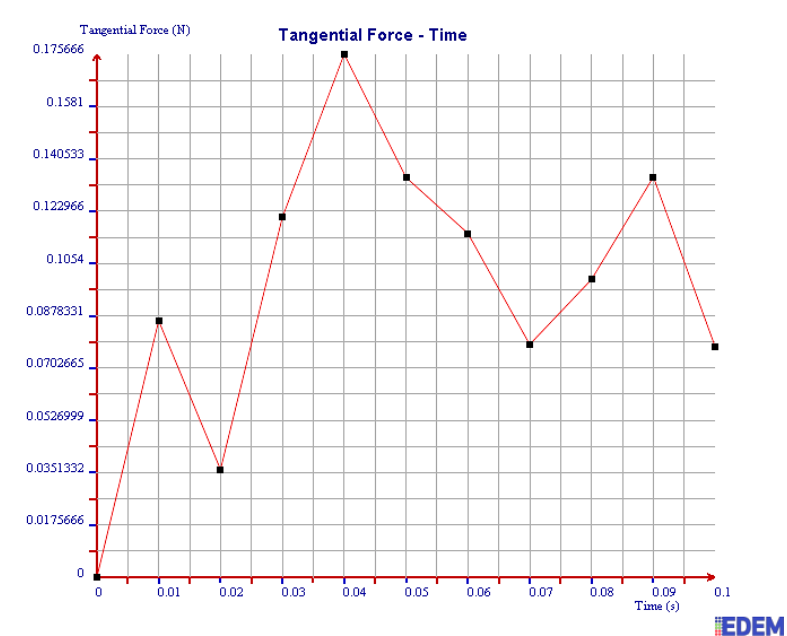
Figure 21. Tangential force of 2 mm chromium balls.